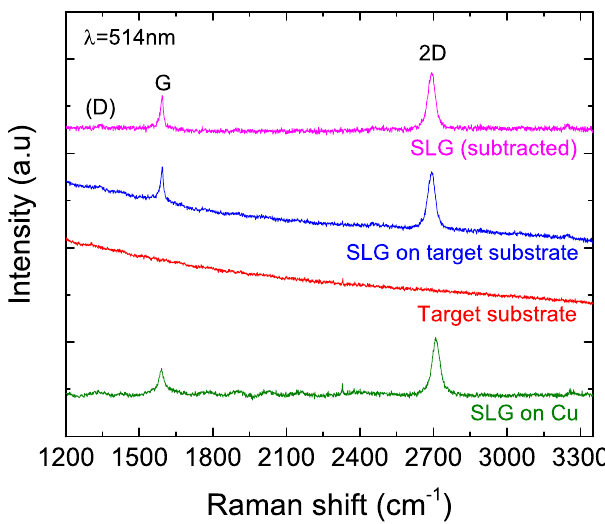
Fig. 5 Raman spectra at 514 nm. Green: SLG on Cu. Red: Au/QD-SAM. Blue: SLG on Au/QD-SAM. Magenta: Spectrum of SLG on Au/QD-SAM after subtracting the spectrum without the